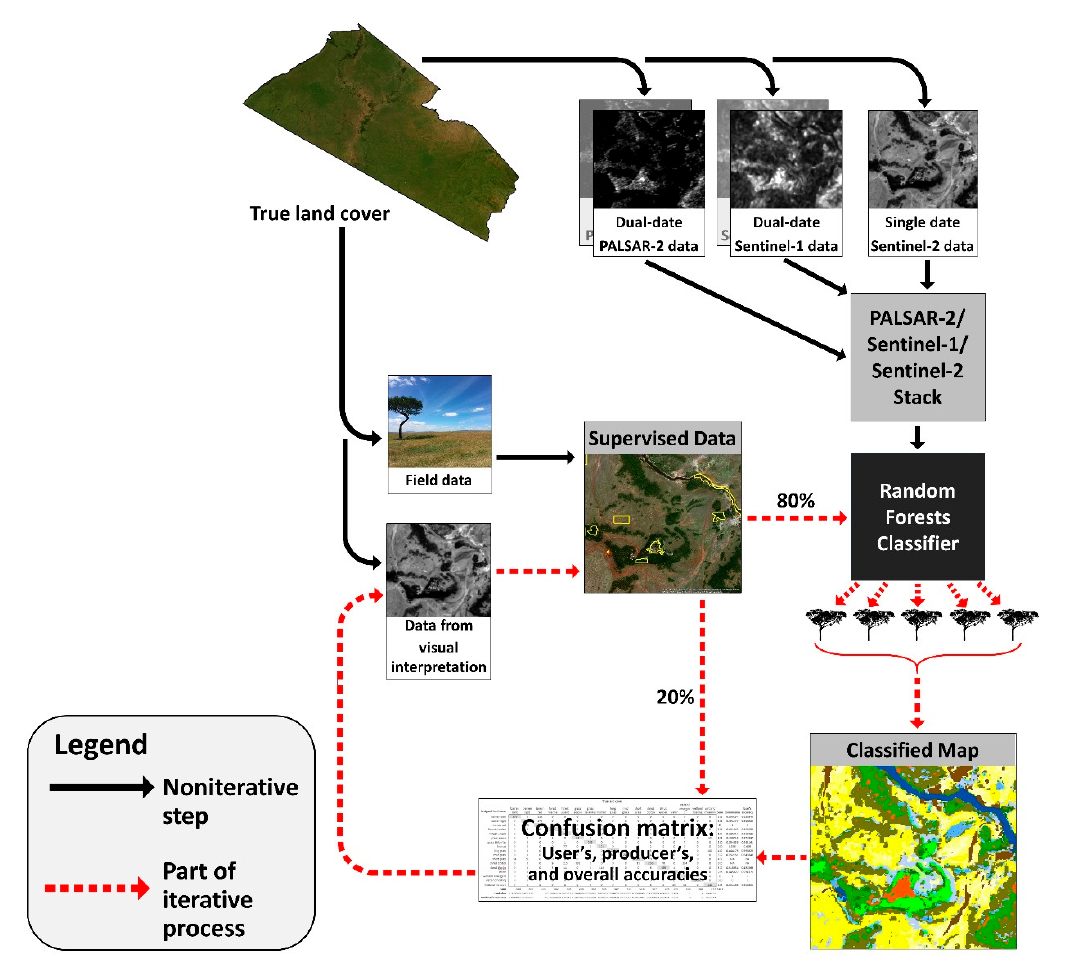
Figure 2. An overview of the land cover classification process. We reserved 20% of the polygons from the supervised dataset for validation, prioritizing field-verified sites. These validation polygons were not used in creating the Random Forests classifier. The other 80% of the supervised data and the multi-sensor composite stack imagery were input into a Random Forests classifier. The validation data were then used to construct a confusion matrix to assess accuracy. Visual inspection of the resultant land cover map and the confusion matrix informed subsequent refinement, addition, and deletion of supervised data and combination of classes.